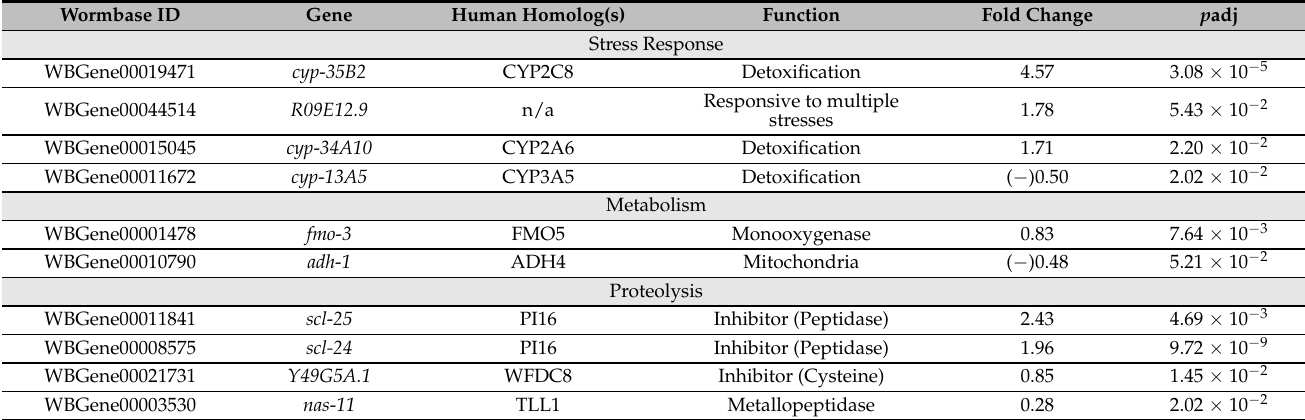
Table 1. Functional Annotation of Day 5 DEGs.